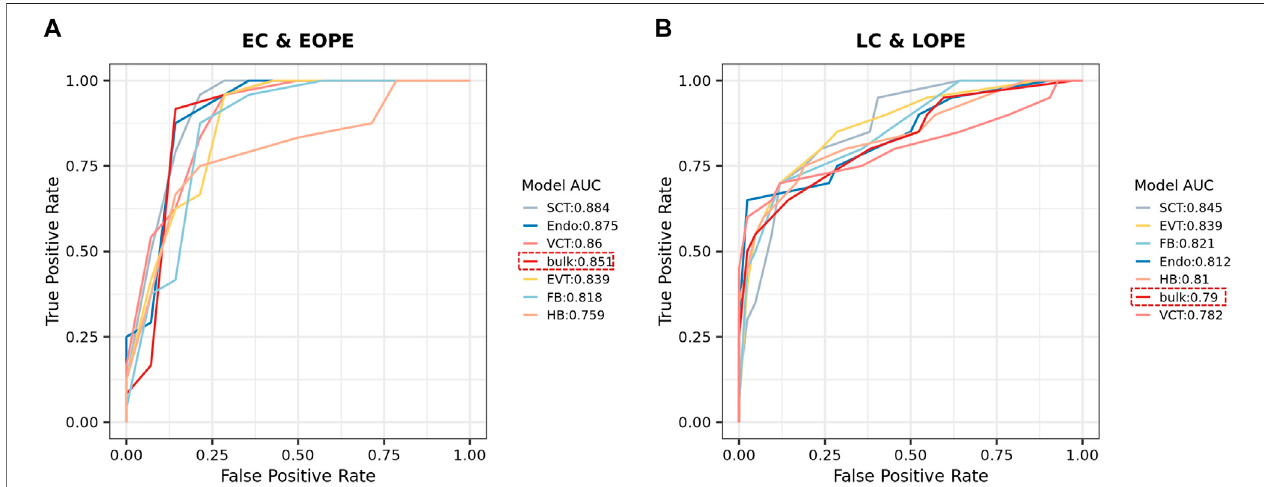
FIGURE 4 | (A,B) ROC of SVM models for distinguishing EOPE (A) and LOPE (B) from their respective groups of normal samples. SVM models were trained by using either the bulk or the predicted cell-type-level expression pro fi